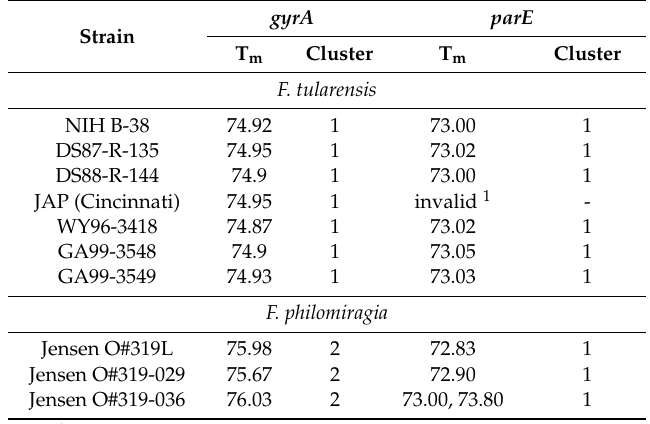
Table5. Highresolutionmeltanalysis(HRMA)melttemperaturesandclustersfor Francisella spp.strains.